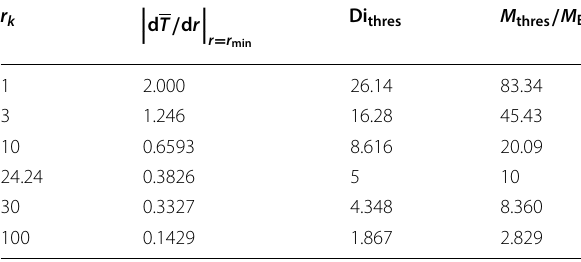
Table 1 The values of the temperature gradient | d T / d r | r = r at the bottom of the fluid layer of 3D spherical shell of r r min / max = 0.5 calculated with several values of the threshold values of dissipation number Di thres and planetary mass M thres divided by the Earth’s mass M E above which regions of stable thermal stratification occur at the bottom of the fluid layer (cid:31) r k (cid:31) (cid:31) d T / d r (cid:31) (cid:31) r = r (cid:31)